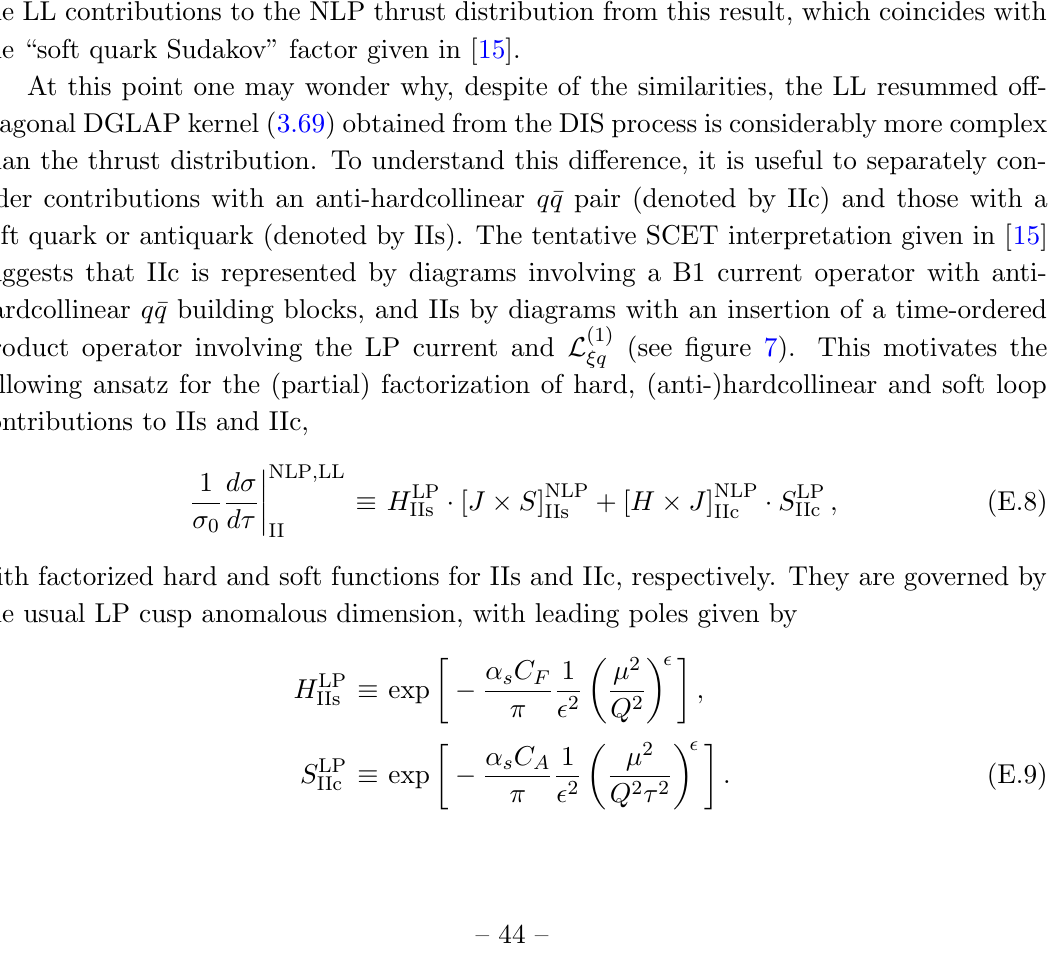
Figure 7 . SCET representation of the content of (E.8) for the thrust distribution in e + e (cid:0) (cid:13) (cid:3) ( Q ) jets at NLP as (cid:28) 0. Wilson lines are set to ! !